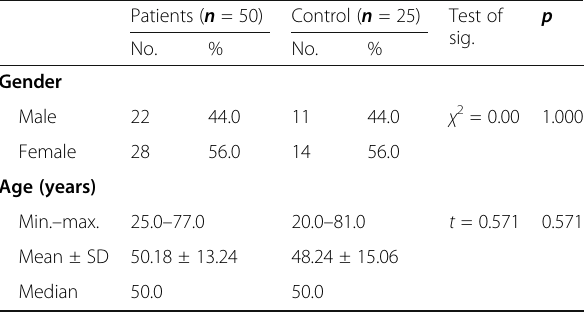
Table 2 Baseline characteristics of the study population Patients ( n = 50)